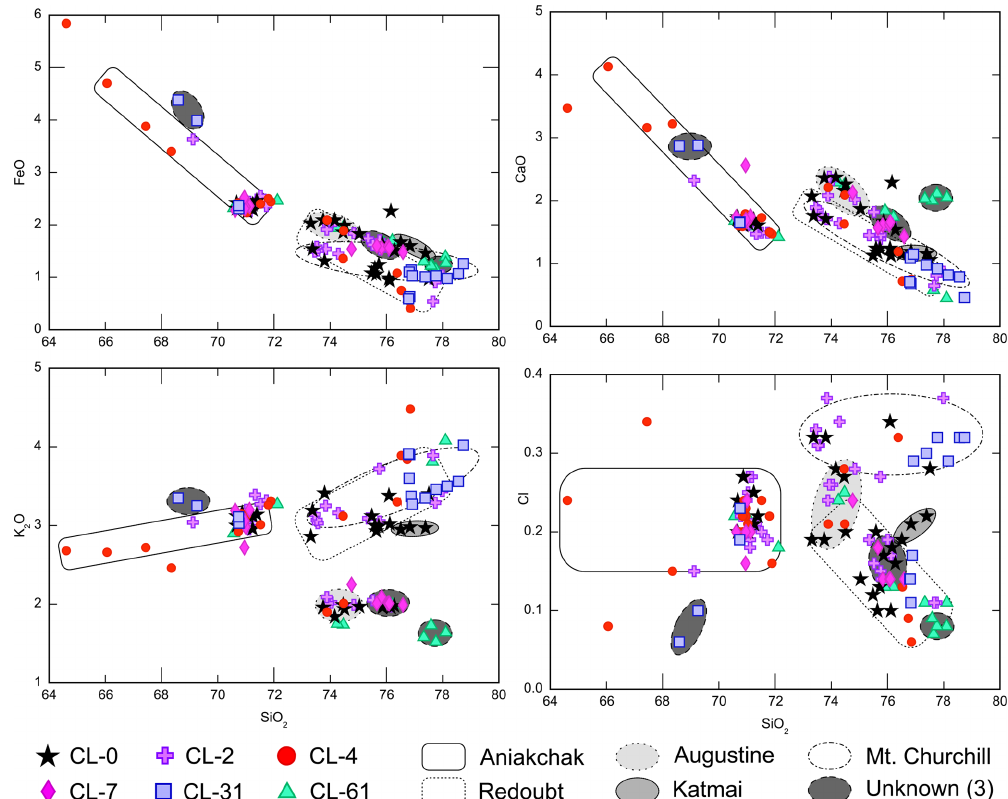
Figure 4. Geochemical biplots showing mixed-glass samples from Cascade Lake. Bounding shapes represent simplified geochemical fields for potential source volcanoes (to aid visualisation). For the full glass geochemical-data ranges associated with these volcanic sources see Bolton et al. (2020), Davies et al. (2016), Fortin et al. (2019) and Zander et al. (2018). Three populations with unknown sources are also shown using the same bounding line and fill. All single-point analysis data are listed in Table